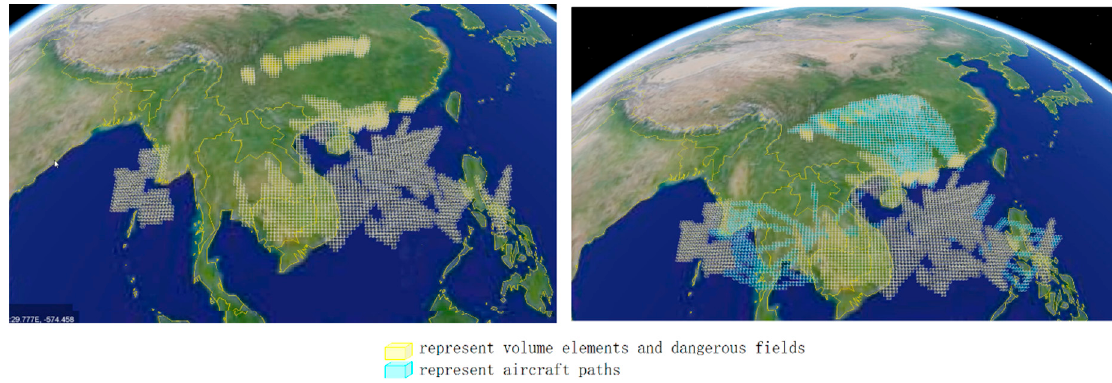
Figure 9. Discretized data expression.